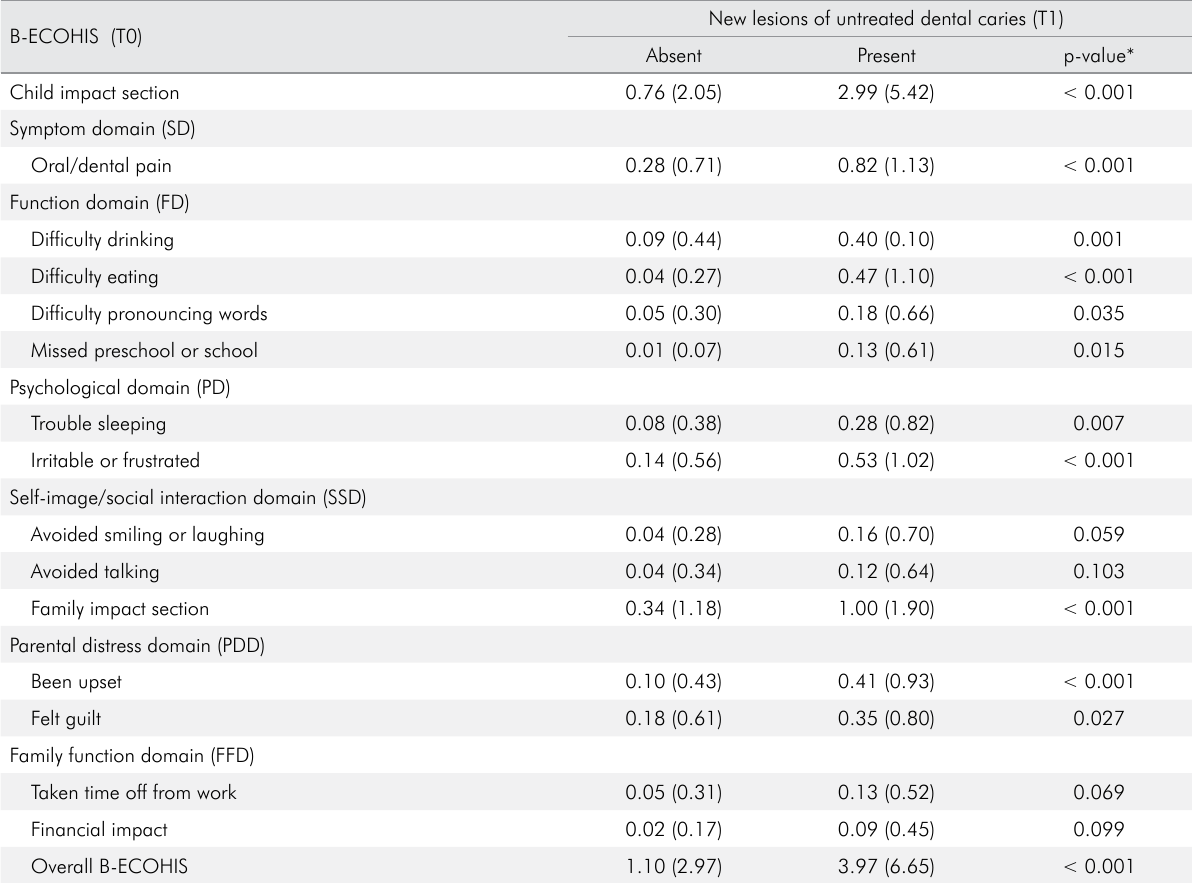
Table 3. Distribution and comparison of mean scores for each item and overall B-ECOHIS at baseline (T0) according to absence/presence of new lesions of untreated dental caries among children in the second examination